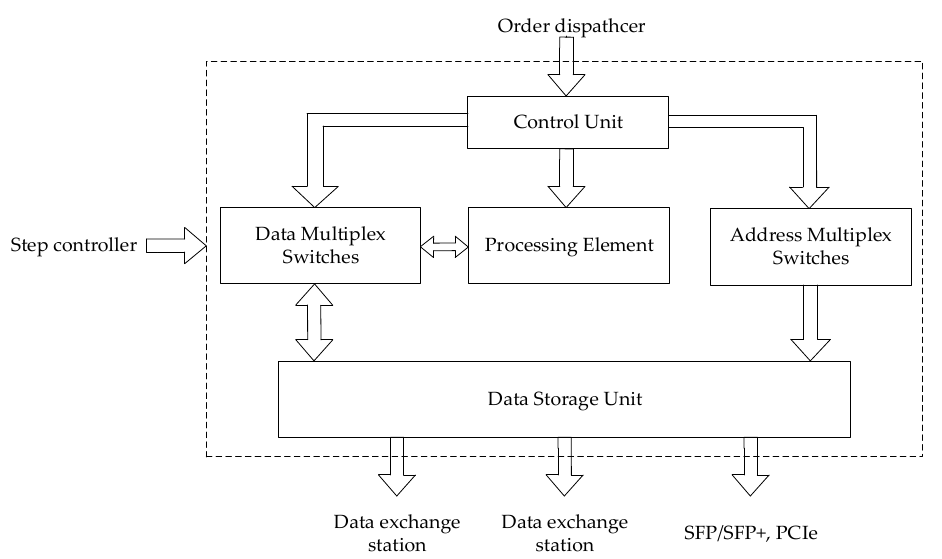
Figure 2. The overall structure of the microprocessor core.